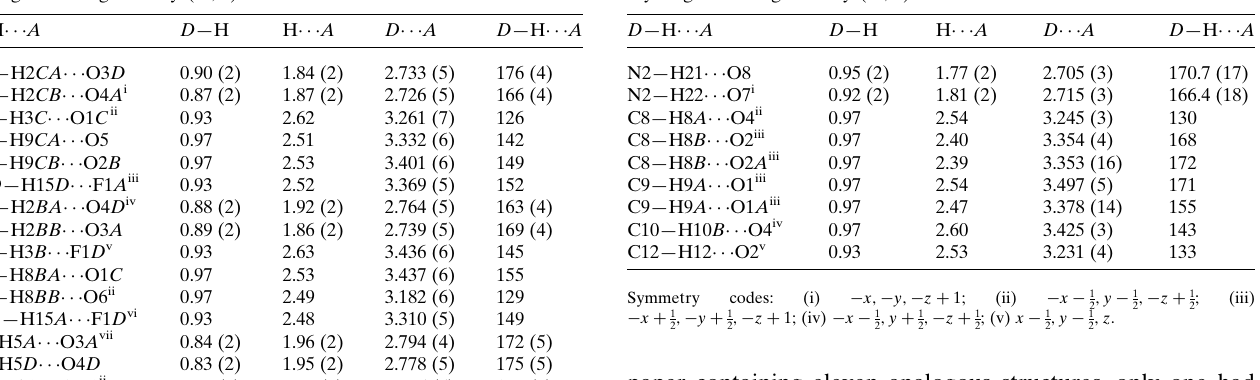
Table 2 Hydrogen-bond geometry (A˚ , (cid:4) ) for 2 .